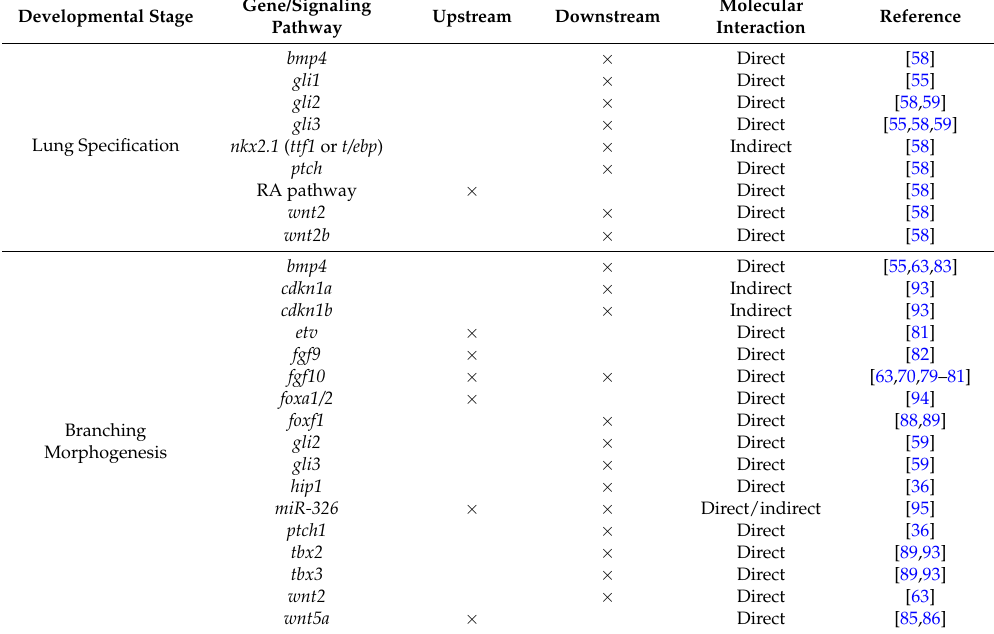
Table 1. Summary of SHH signaling upstream and downstream targets that contribute to early lung